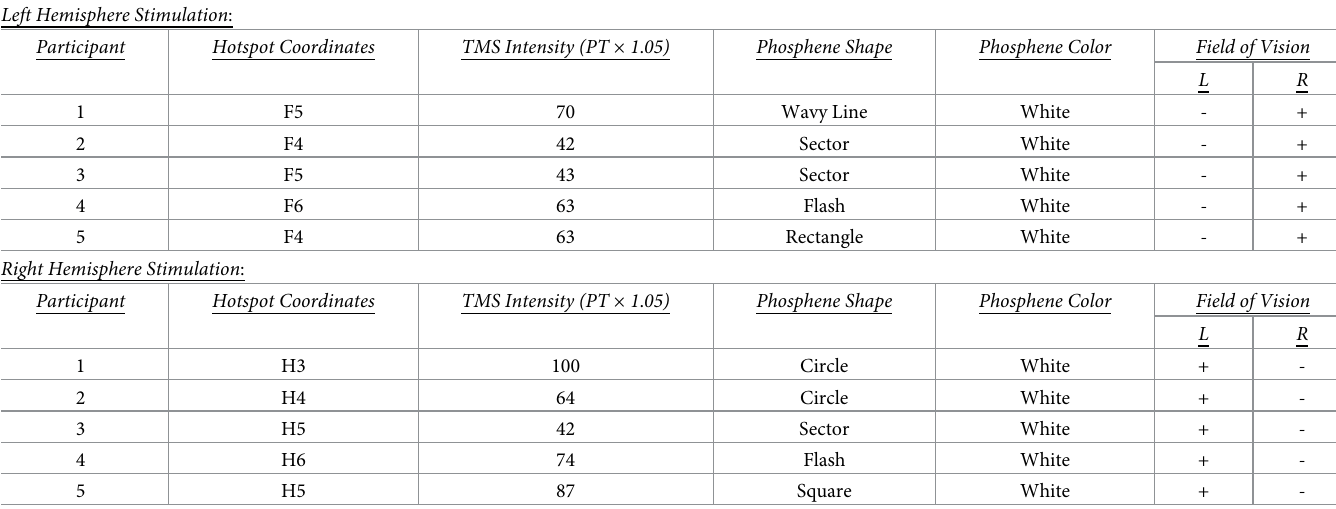
Table 2. Participant phosphene information.